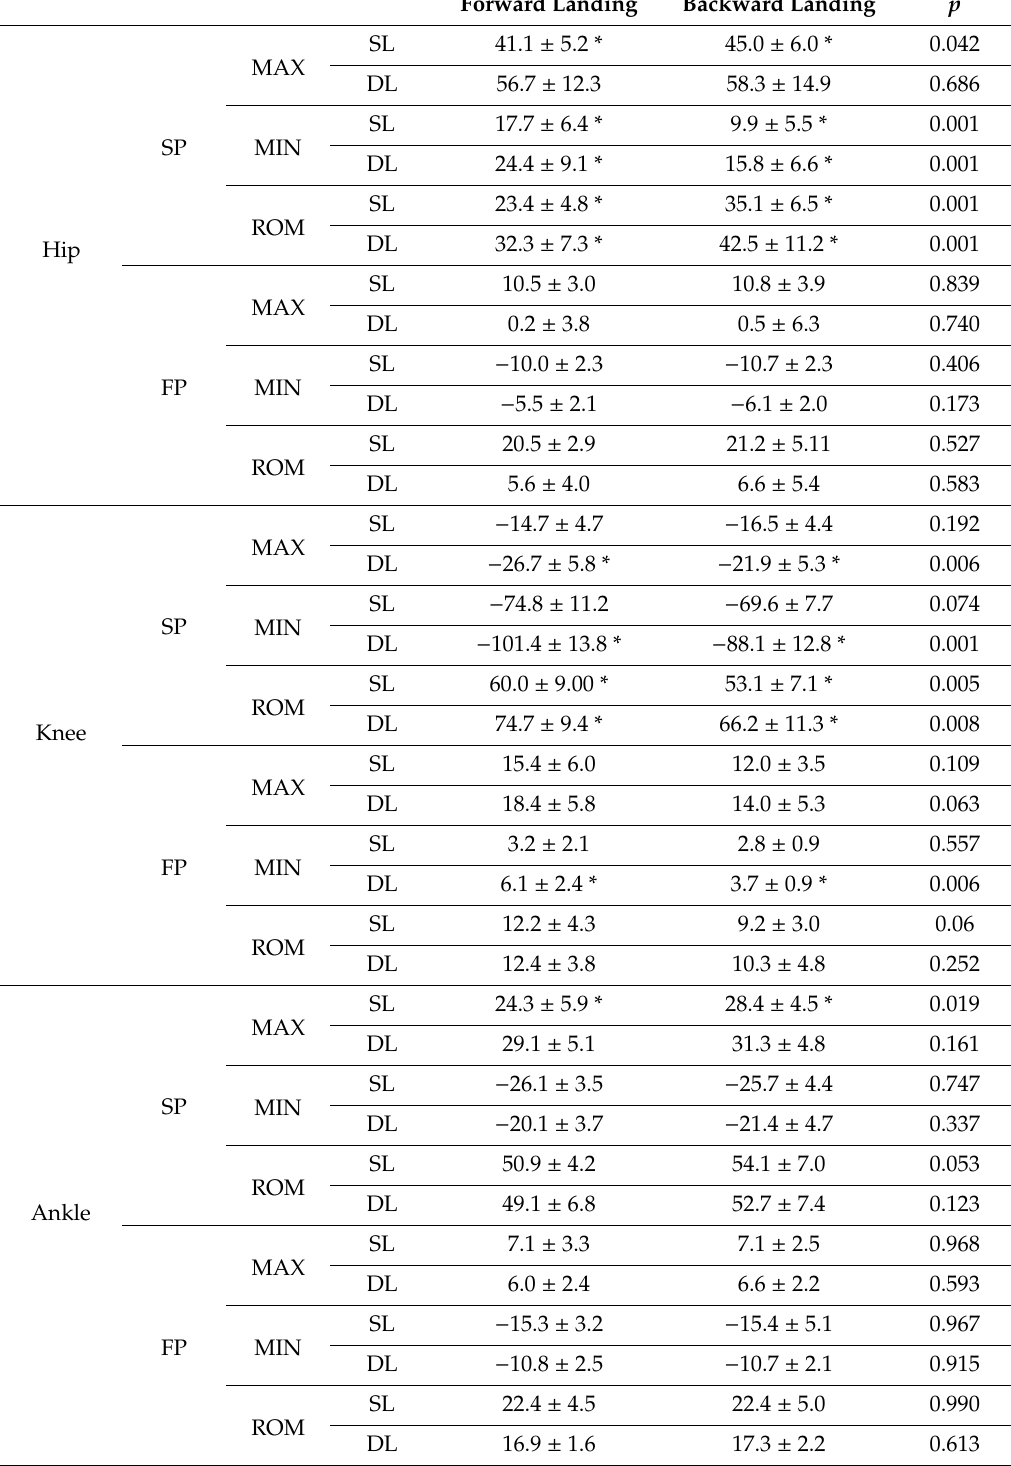
Table 1. The hip peak joint angle and range of motion (ROM) of the joint angle during the landing phase between forward landing and backward